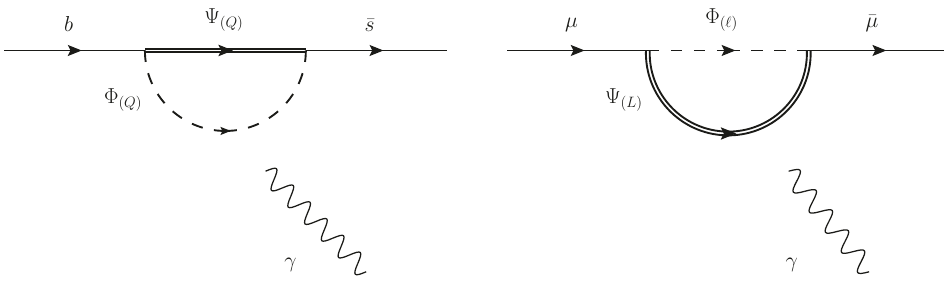
Figure 4 . Loop contributions to b ! s(cid:13) and the anomalous magnetic moment of the